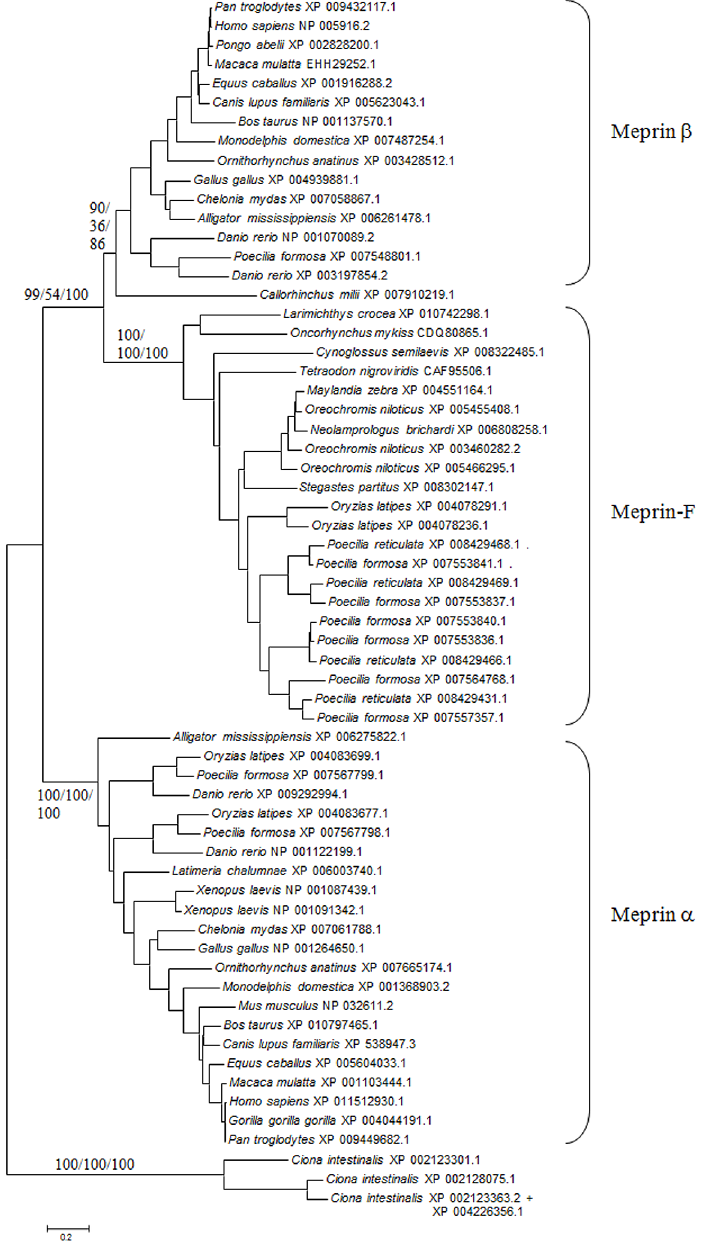
bootstrap support (1000 replicates for NJ and 200 replicates for either MP or ML). Only the values for the most external, critical branches are shown. ML trees were obtained using the WAG + G + I model, while MP trees were obtained using the TBR search